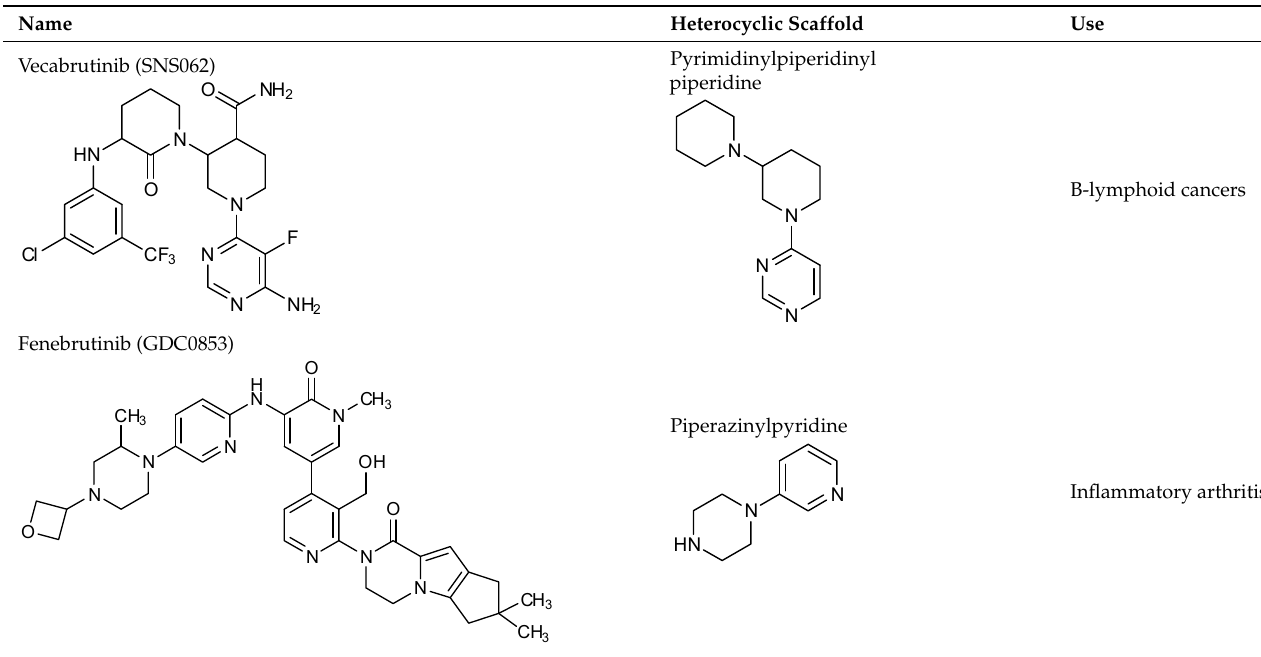
Table 2. Non-covalent inhibitors of BTK under clinical trials.